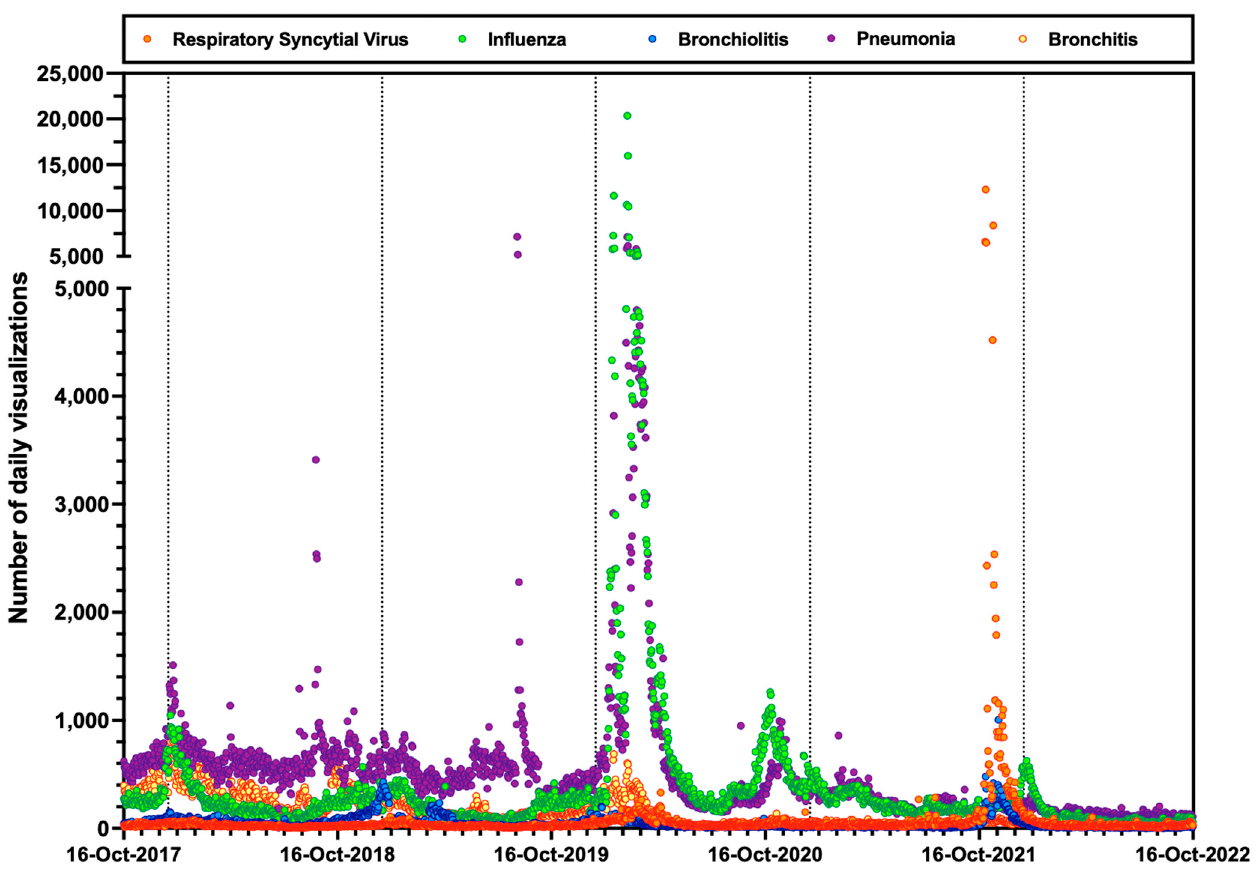
Figure A3. Seasonal trends for daily visualization for the following Wikipedia pages: Respiratory Syncytial Virus; Influenza; Bronchitis, Pneumonia; and Bronchitis.